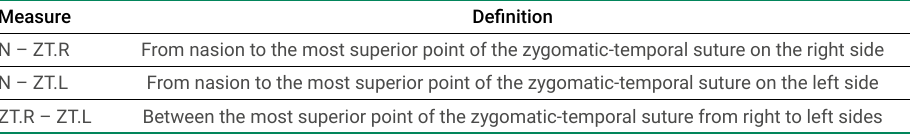
Table 1. Abbreviation and definition of the measures taken Measure